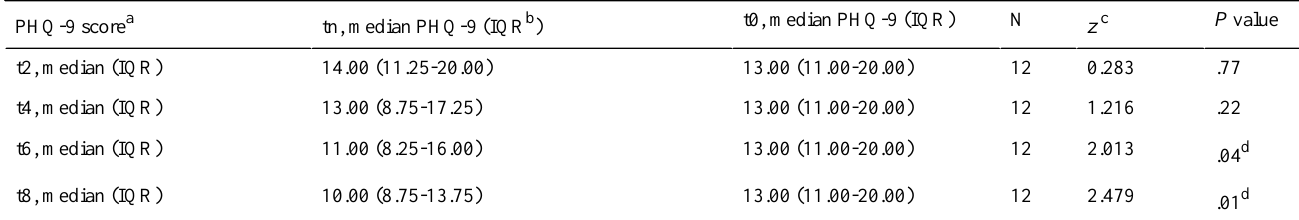
Table 3. Wilcoxon signed rank test results between t and t n